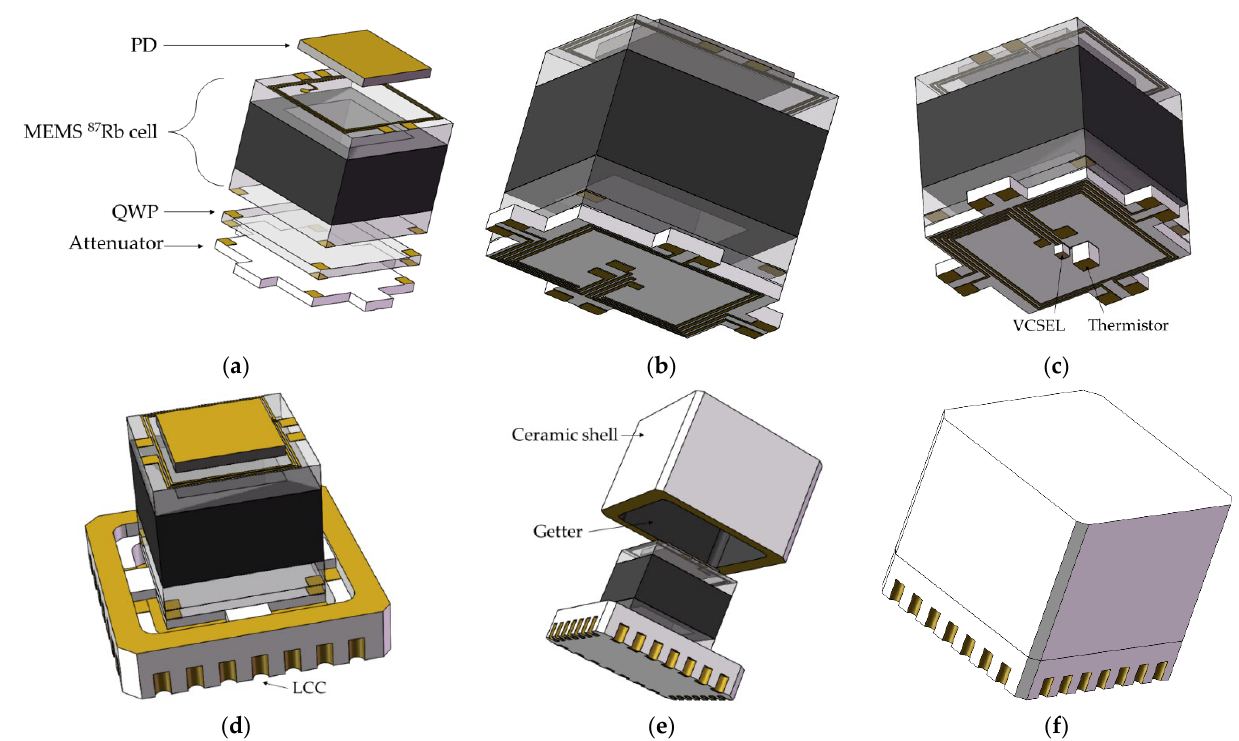
Figure 3. Integration process of the physics package: ( a ) explosive view of Part A; ( b ) integration of Part A; ( c ) integration of Part B; ( d ) integration of Part C; ( e ) an uncompleted physics package; ( f ) a completed physics package.